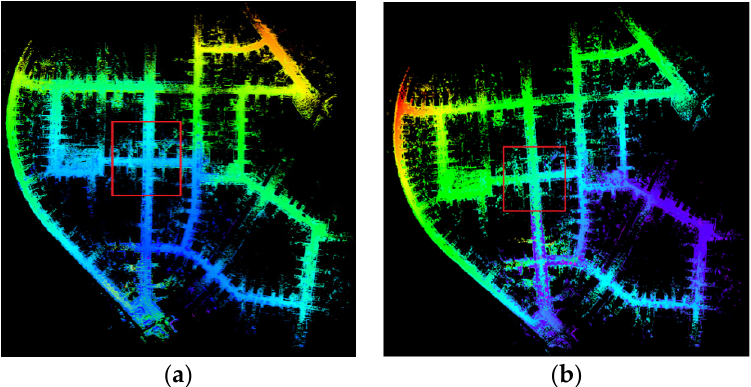
Figure 4. Point cloud map of the KITTI dataset 00 sequence constructed by the LeGO-LOAM and LeGO-LOAM-SM. Color represents elevation: ( a ) LeGO-LOAM; and ( b ) LeGO-LOAM-SM.